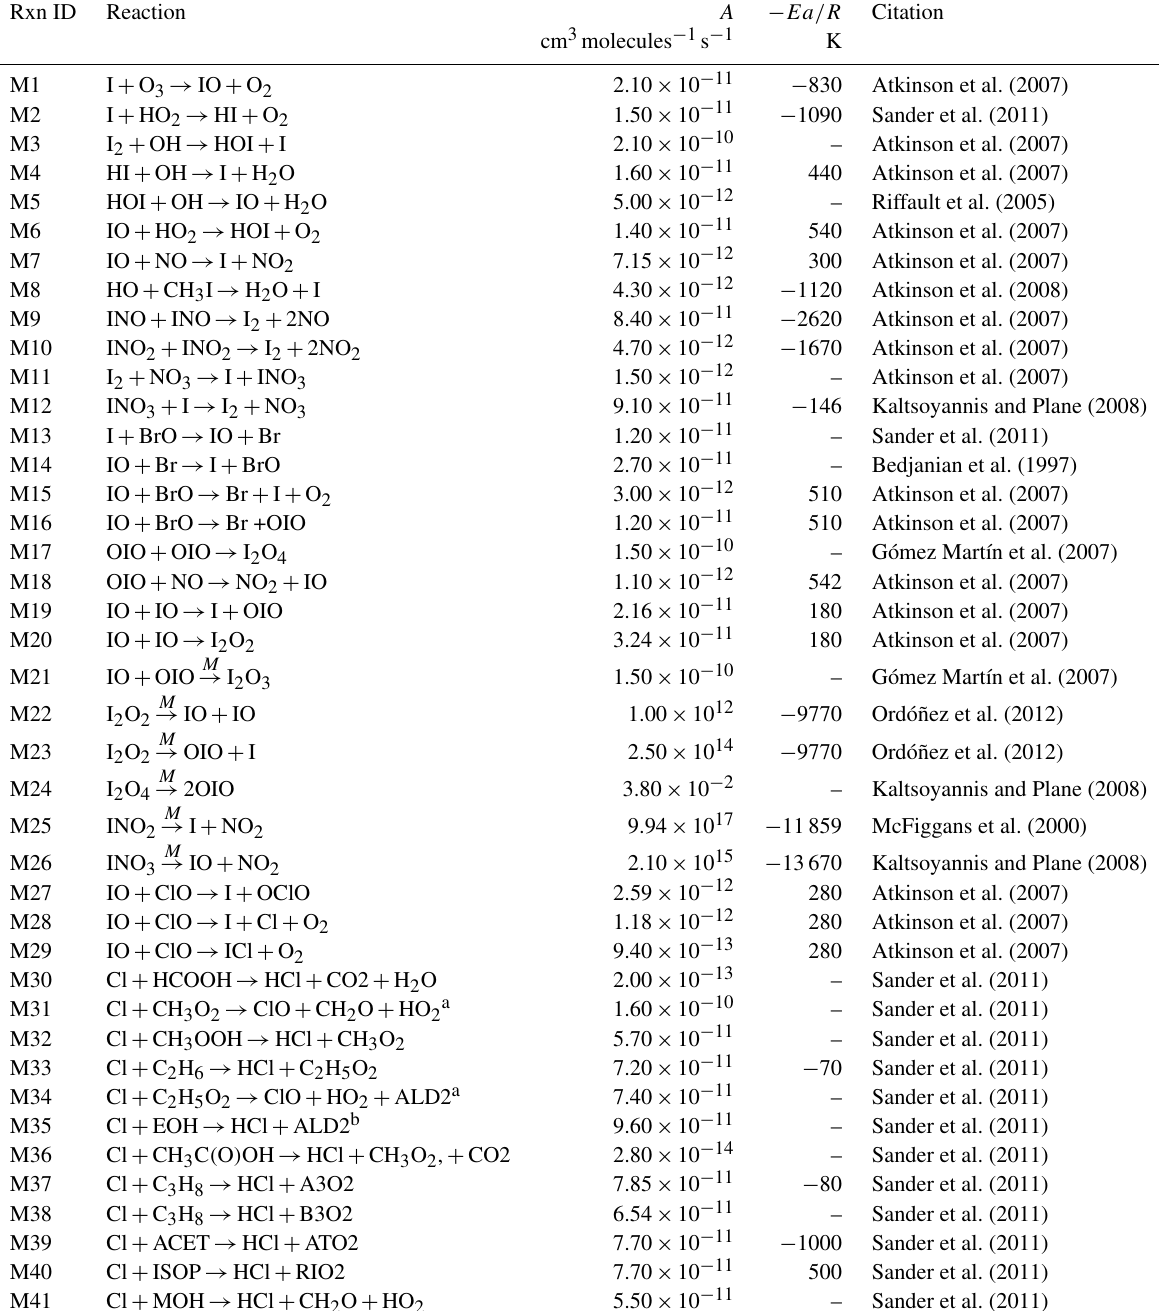
Table B2. Bimolecular halogen reactions included in scheme. This includes reactions from previous updates to descriptions of halogen chemistry in GEOS-Chem (Eastham et al., 2014; Parrella et al., 2012; Schmidt et al., 2016; Sherwen et al., 2016a) and those described in ) . Unknown values are represented by a dash and these set Sect. 2. These are given in the Arrhenius form with the rate equal to A · exp ( − Ea RT to 0 in the model, reducing the exponent to 1. The bi-molecular reactions with an M above the arrow represent termolecular reactions where the pressure dependence is not known or are uni-molecular decomposition reactions. Abbreviations for tracers are expanded in Appendix